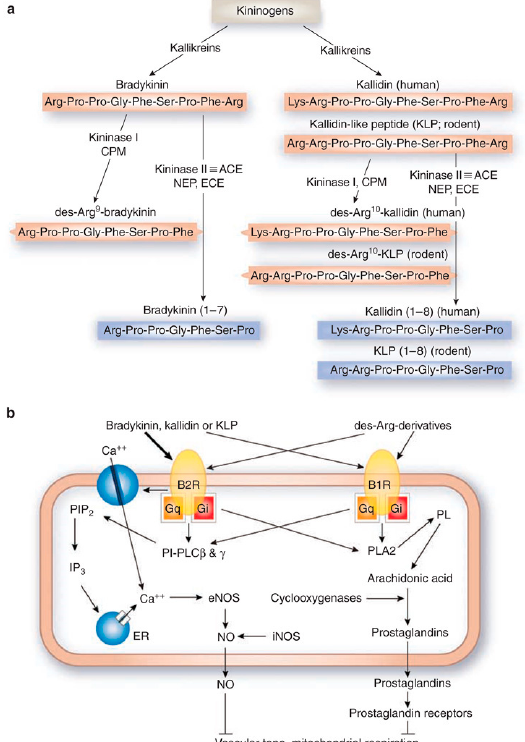
Figure 1. Components and signaling of the kallikrein–kinin system. ( a ) Biosynthesis and metabolism of kinins. Kininogens are processed by kallikreins to produce bradykinin and kallidin. Kininase I removes the carboxyl-Arg from bradykinin and kallidin to yield des-Arg 9 -bradykinin and des-Arg 10 -kallidin, respectively. Enzymatic cleavage by kininase II (angiotensin I-converting enzyme), neprilysin, and endothelin-converting enzyme can inactivate kinins. CPM, carboxypeptidase-M; ACE, angiotensin I-converting enzyme; NEP, neprilysin (endopeptidase 24.11); ECE, endothelin-converting enzyme; red, active peptides; blue, inactive peptides. ( b ) Binding of kinins to bradykinin receptors and intracellular signaling. The thickness of arrows arising from the kinins indicates the relative potency of each peptide to elevate intracellular calcium concentrations. PIP2, phosphatidylinositol-4,5-bisphosphate; PI-PLC, phosphatidylinositol-specific phospholipase C; IP3, 1,4,5-inositol triphosphate; ER, endoplasmic reticulum; PL, phospholipids; PLA2, phospholipase A2; NO, nitric oxide; eNOS, endothelial NO synthase; iNOS, inducible NO synthase. Figure reproduced from Kakoki, M., et al.